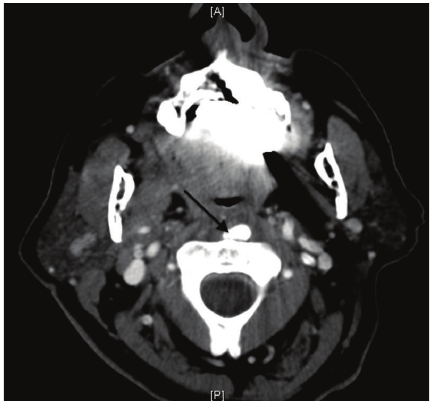
Figure 4: Axial CT of the neck with IV contrast shows calcifications anterior to the body of C2